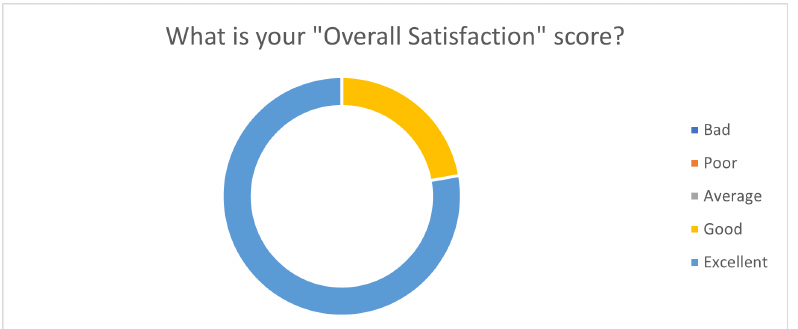
Figure 20. Overall satisfaction